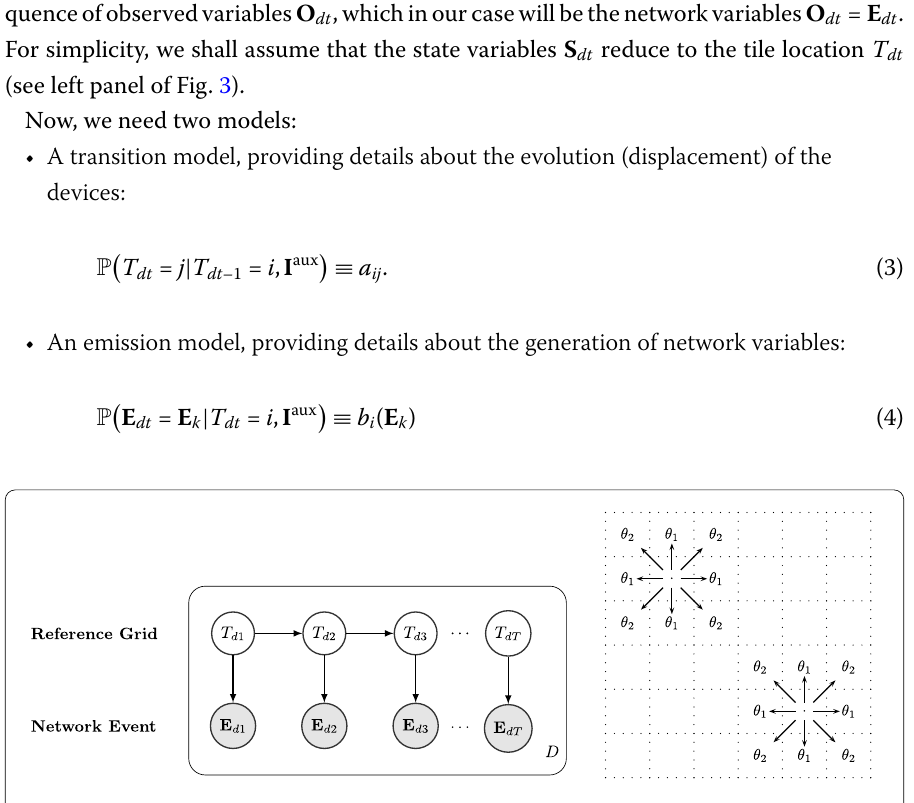
Figure 3 Graphical representation of a hidden Markov model. (Left) Observed variables are network variables E dt and unobserved variables are tile locations T dt . (Right) Transition probabilities in the reference grid for adjacent